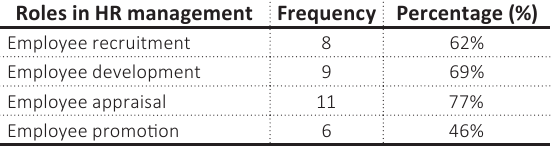
Table 2. Respondents’ roles in human resource